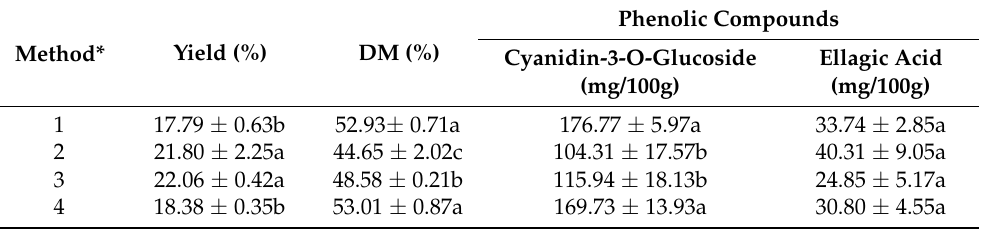
Table 1. Yield, degree of methyl-esterification (DM) and phenolic contents of the pectins obtained from jabuticaba peel using different extraction methods.